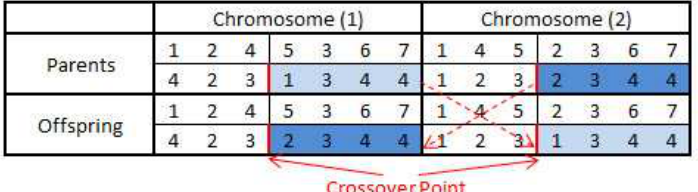
Figure 8. Example of